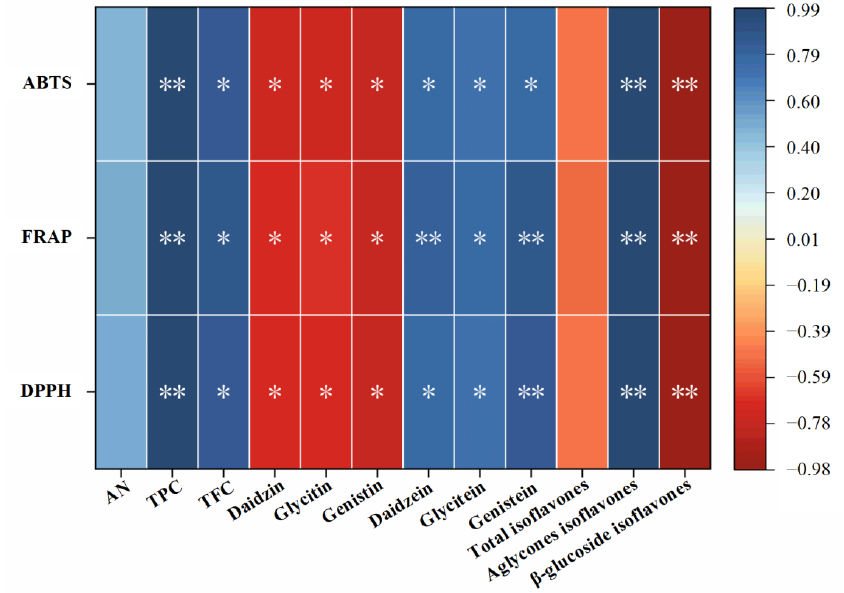
Figure 7. Correlation of the bioactive components and the antioxidant capacity of Douchi koji (* p < 0.05, and ** p < 0.01). and ** p <